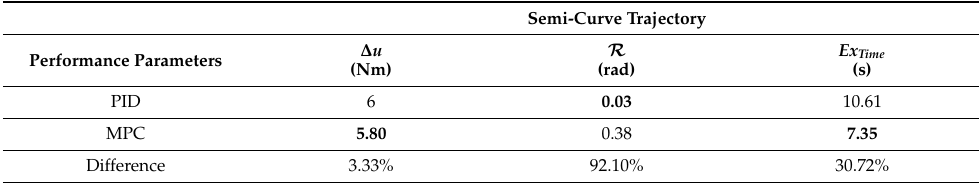
Table 6. Results of the simulation relating to the performance parameters of the semi-curve reference